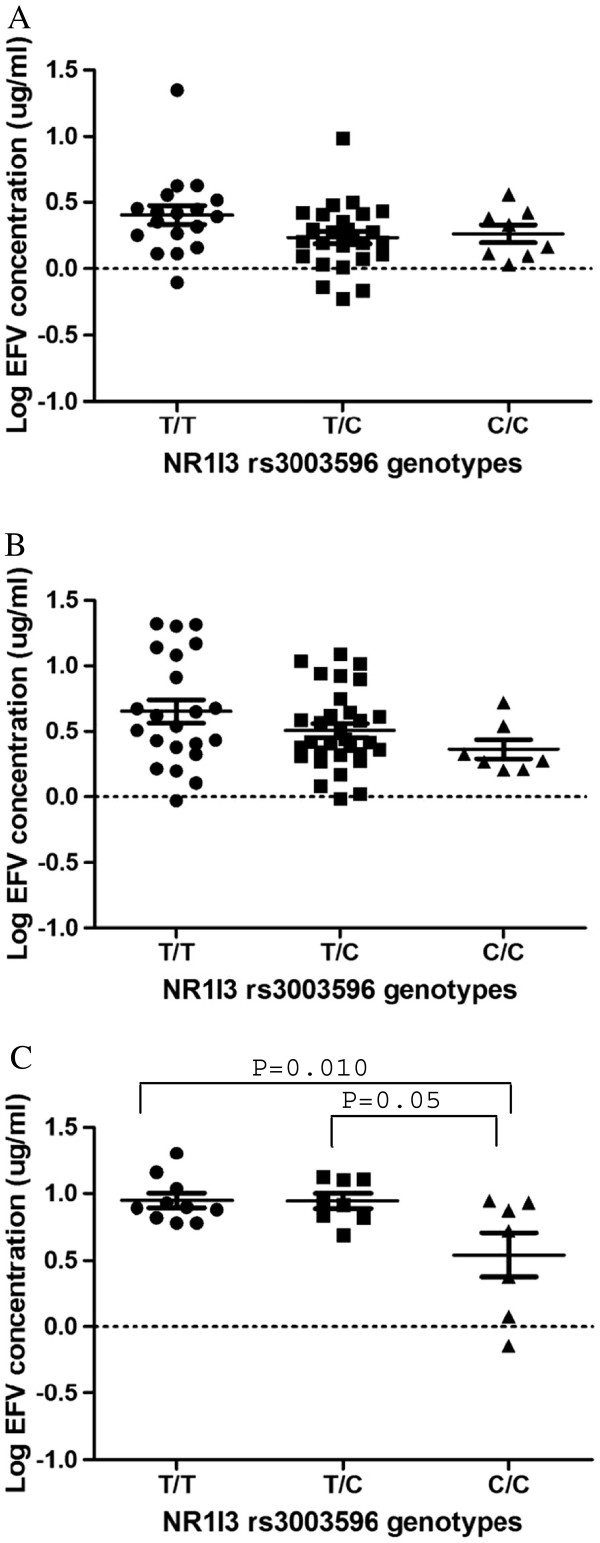
A-C: Effects of NR1I3 rs3003596 and CYP2B6 G516T variation on plasma efavirenz concentration.A) NR1I3 rs3003596 stratified by CYP2B6 516G/G. B) Stratified by CYP2B6 516G/T.C) Stratified by CYP2B6 516T/T. Only significant P-values are indicated.